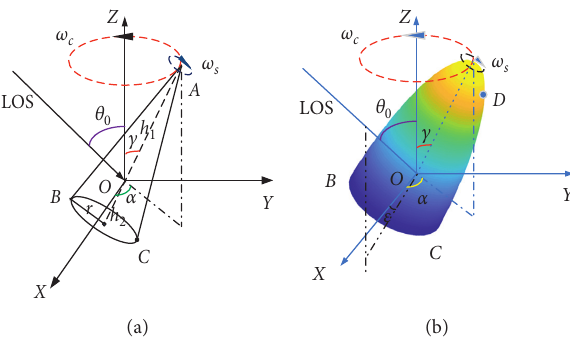
Figure 2: The micromotion model for the warhead target: (a) cone warhead target; (b) streamlined structure warhead